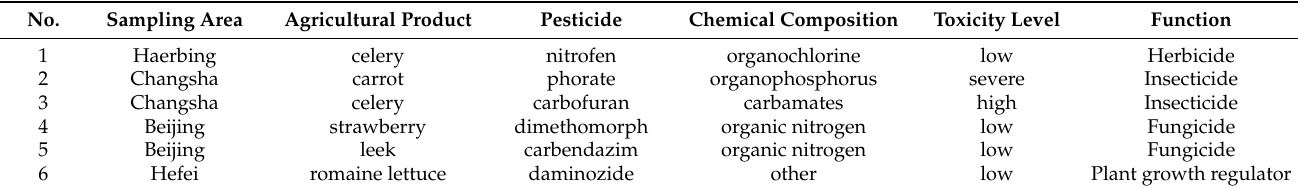
Table 5. Records (partially) for association rule mining.